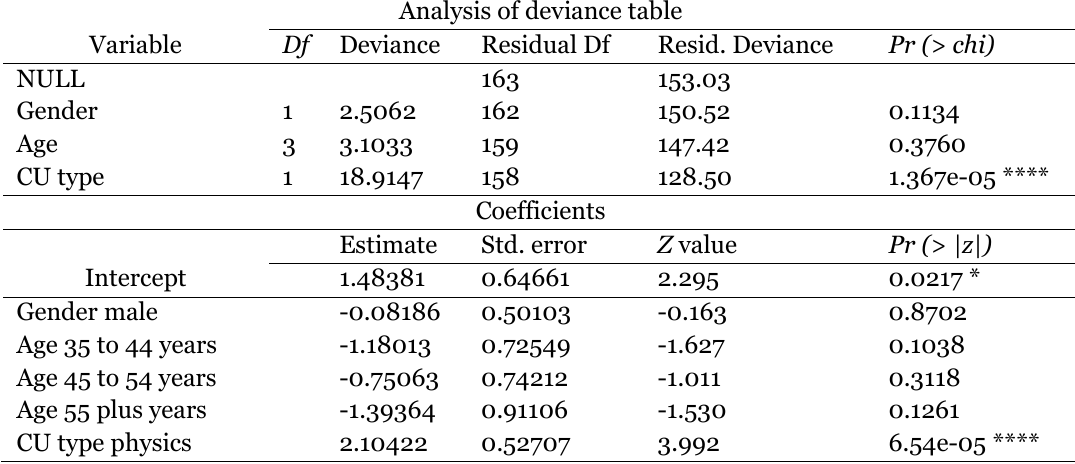
Significance of Using Wikipedia